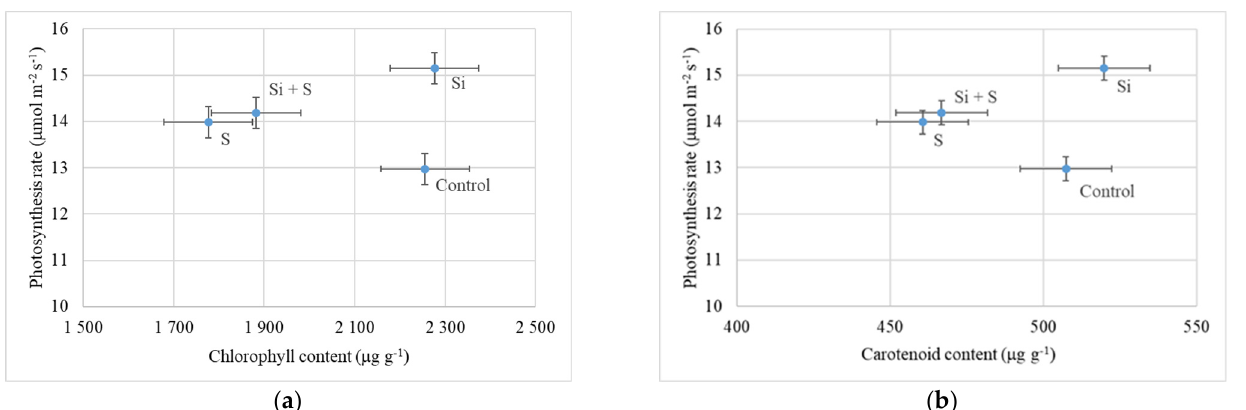
Figure 9. ( a ) Photosynthesis rate of oat as a function of chlorophyll content (27 May, BBCH52); ( b ) Photosynthesis rate of oat as a function of carotenoid content (24 June, BBCH77). Means of the varieties, ± standard error.